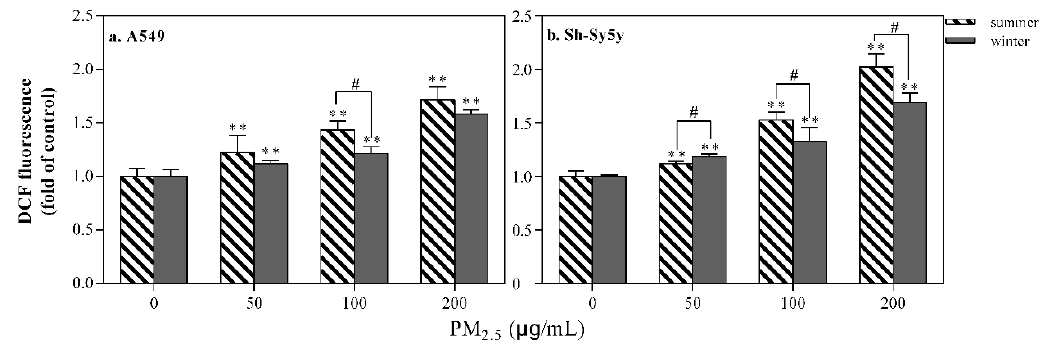
Figure 6. The relative change in reactive oxygen species (ROS) production in A549 and Sh-Sy5y cells exposed to different levels of PM 2.5 . (* p < 0.05, ** p < 0.01: Significant differences between each treatment group and the control group was; # p < 0.05, ## p < 0.01: Significant differences between summer and winter samples).